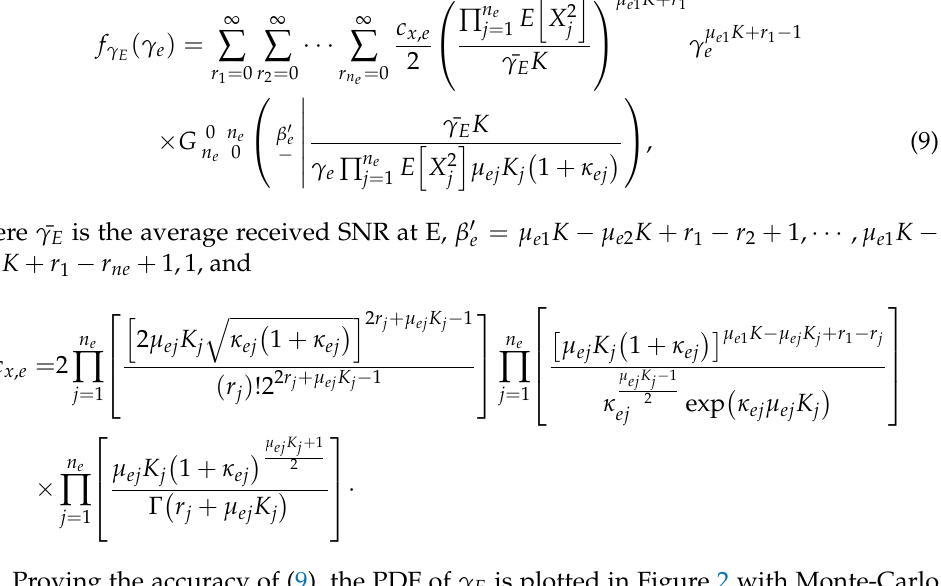
= − µ + µ − r + r · · · , − µ e 2 K e 1 K 2 , 1 e (cid:104) (cid:105) (cid:0) (cid:1) E X 2 µ ej K j 1 + κ ej j j = 1